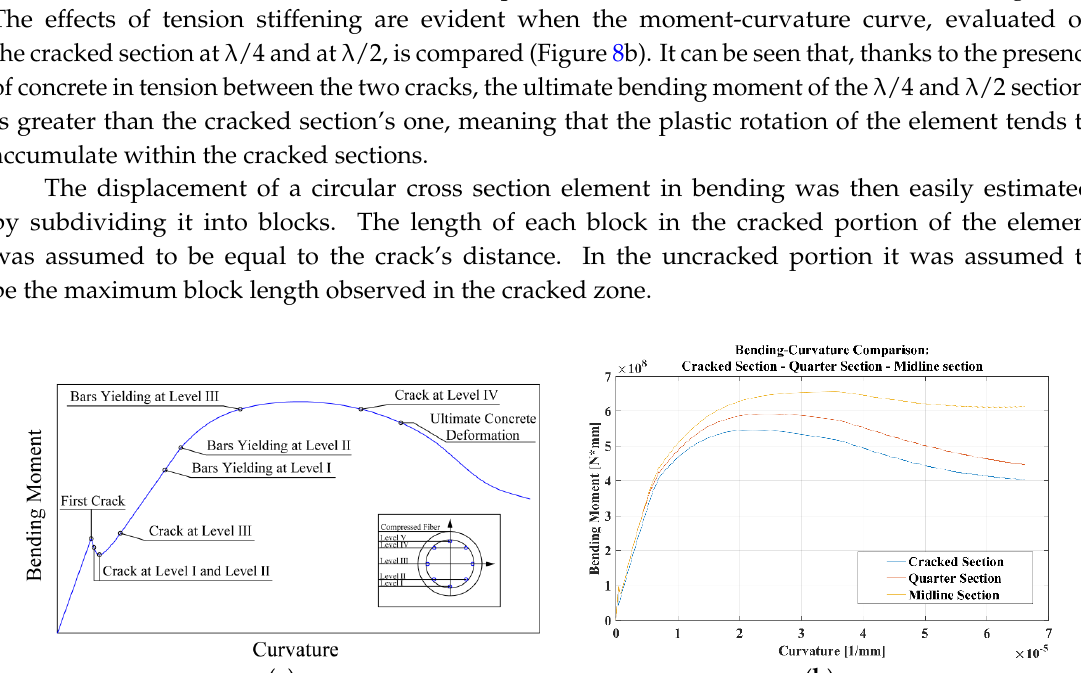
Figure 8. Examples of the moment-curvature curve computed for the circular pile studied by Teherani [16]: ( a ) typical shape for the cracked section; ( b ) comparison between the computed behaviors at cracked, λ /4, and λ /2 sections.